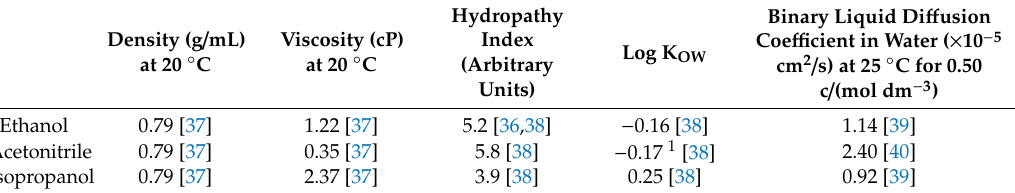
Table 1. Density, Viscosity, Hydropathy Index, Log K ow , and Di ff usion Coe ffi cients for the Solvents.